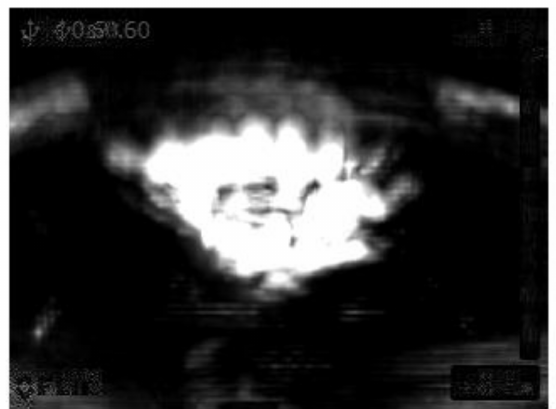
Figure 17. Computed matrix sum_avg (for the BLDC of the fan). The value of M , the maximum of matrix sum_avg is equal to 2.8784 for the considered training thermal images. This maximum is used for the equation m = p × M . The author analyzed the following p parameters: 0; 0.3; 0.5; 0.7; 0.9; 1.0. Next, step 7 was performed: C = TI + sum_avg − G . The thermal images of the healthy BLDC motor at 2100 rpm for different parameters p are shown in Figure 18.